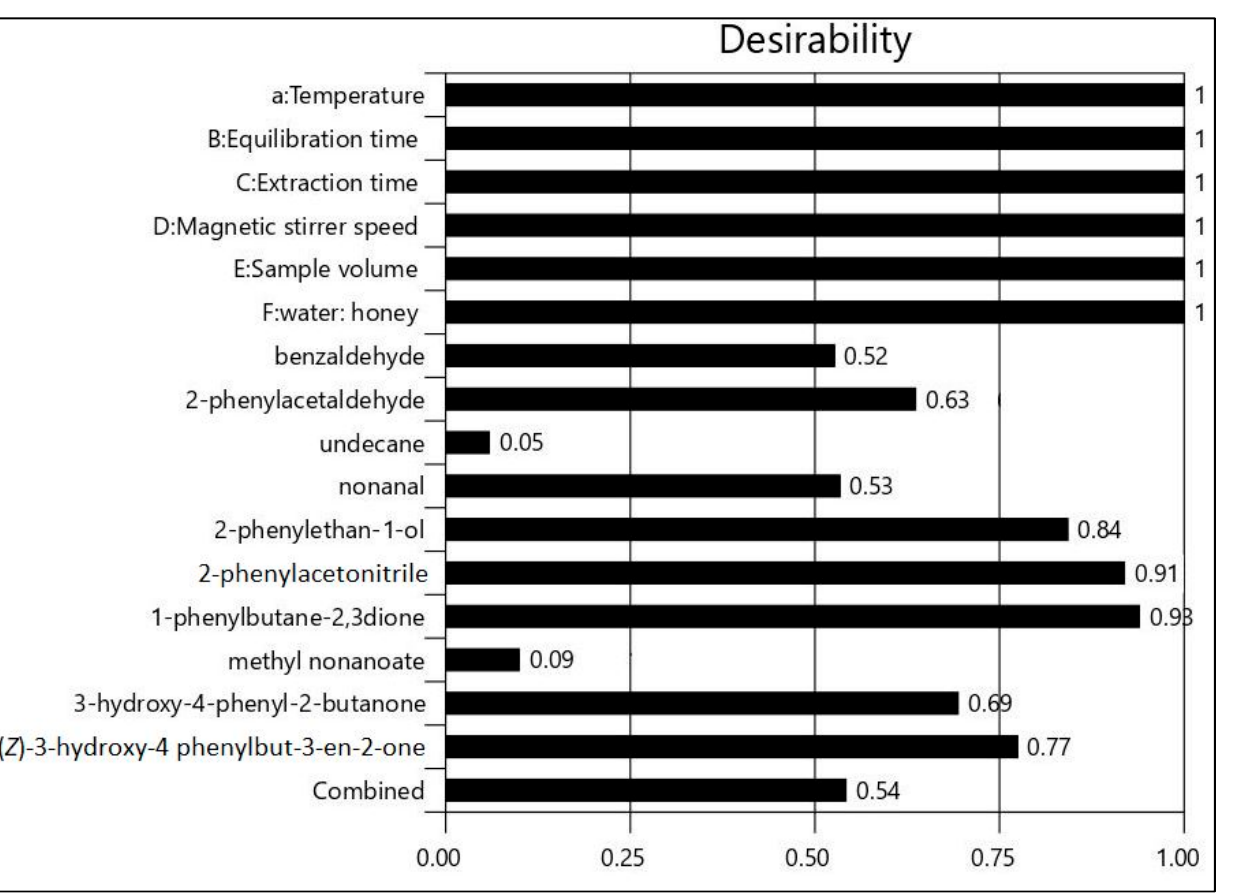
Figure 5. Desirabilities of overall volatile compound responses based on optimum isolation conditions.